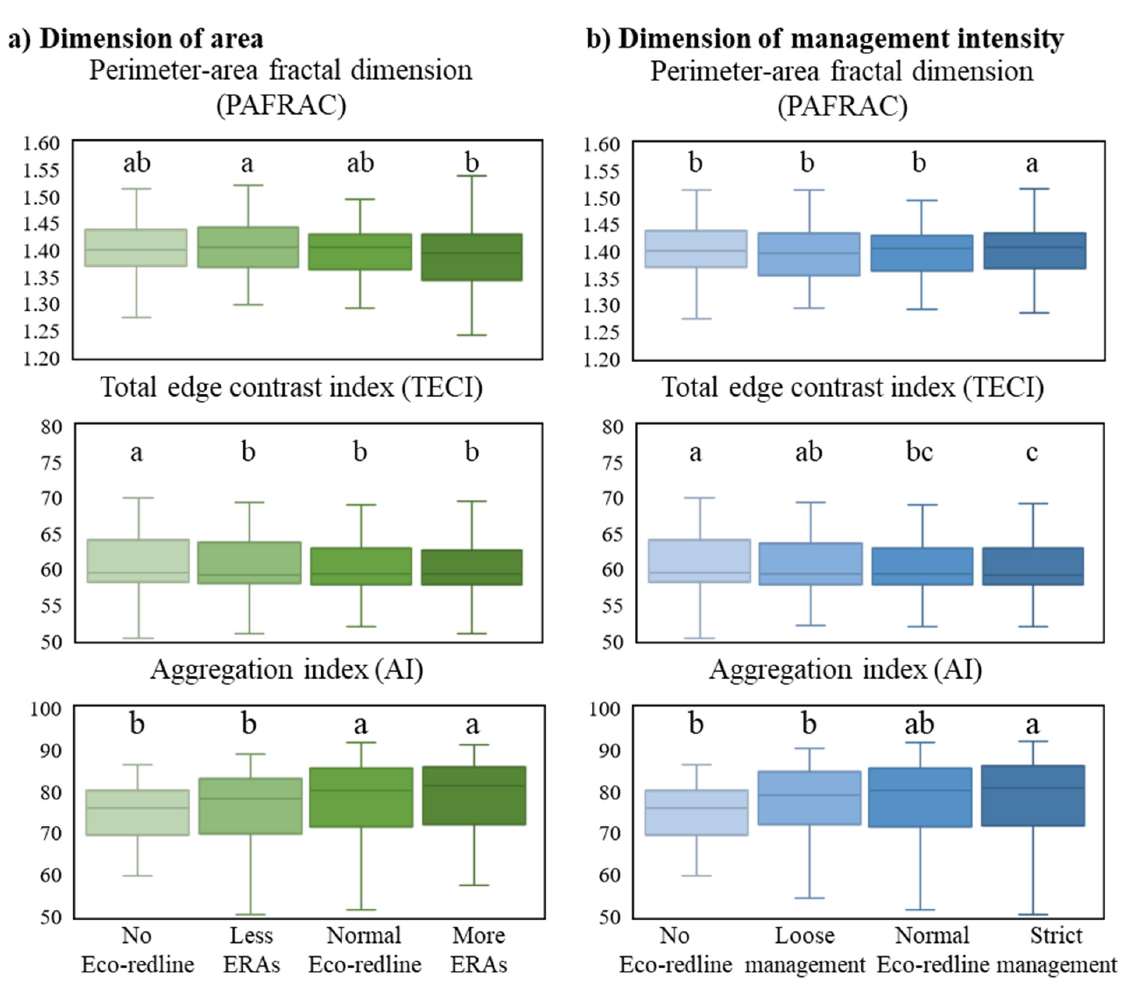
Figure 9. The median, first quartile, third quartile, minimum, and maximum values of the Perimeter-Area fractal di- mension (PAFRAC), Total edge contrast index (TECI) and Aggregation index (AI) and the statistical analysis results ( p < 0.05), ( a ) demonstrates the change with the area dimension and ( b ) demonstrates the change with the management intensity